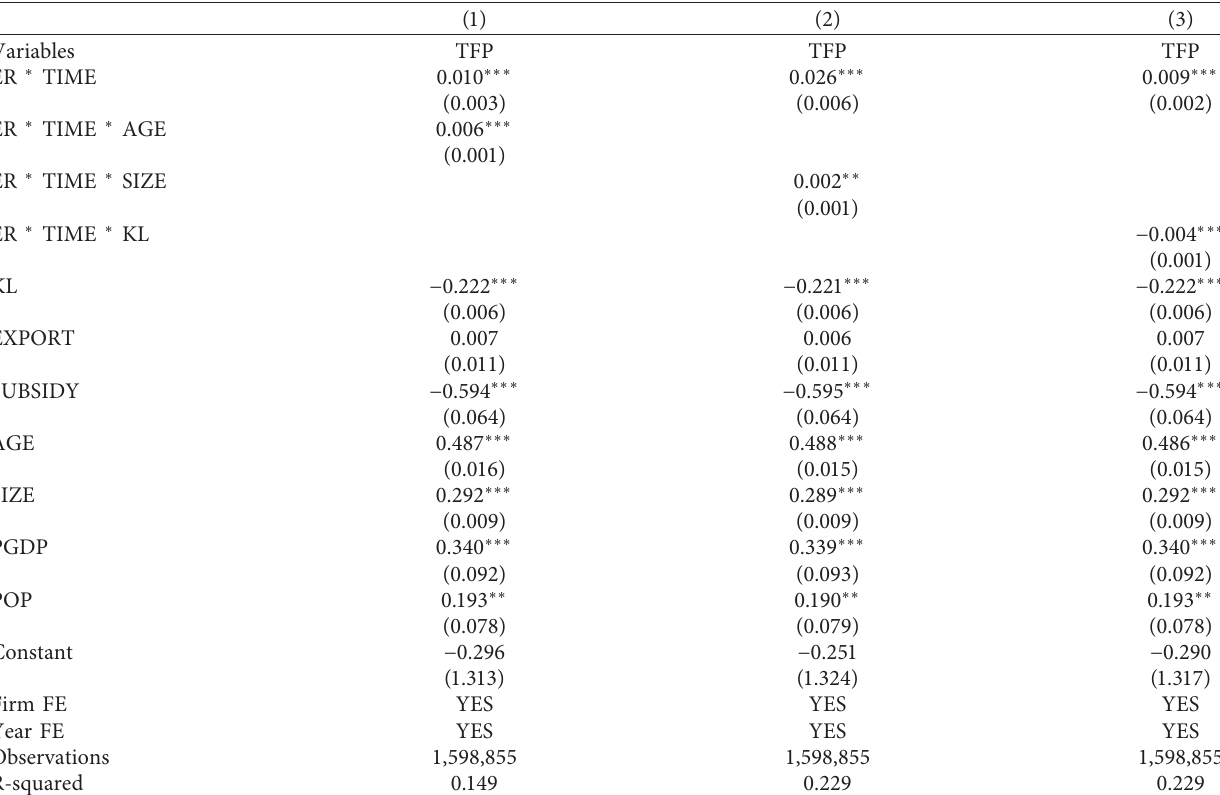
Table 3: Regression results containing different firm